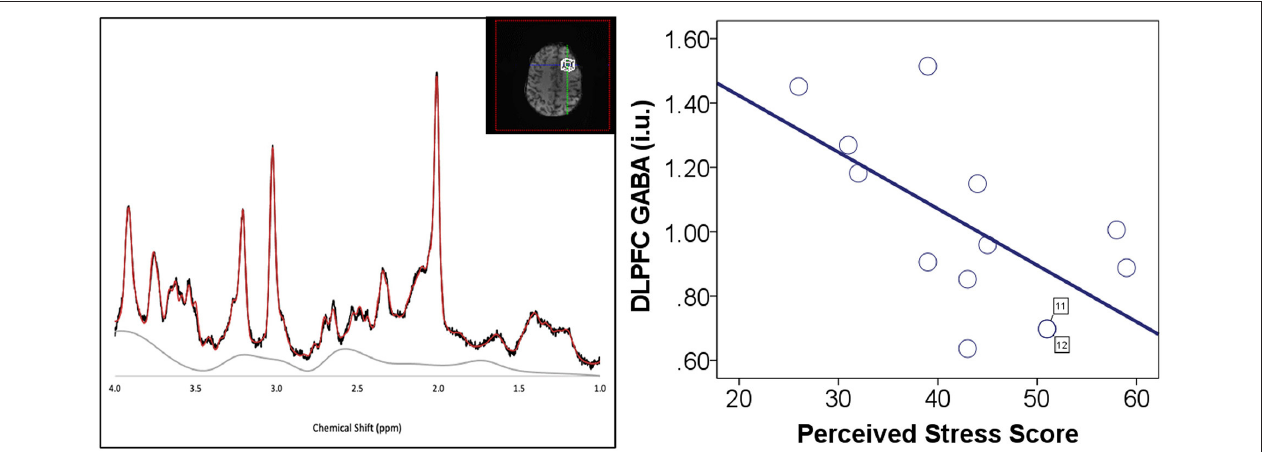
FIGURE 1 | Perceived stress and DLPFC GABA. (Left) DLPFC voxel placement and example of spectrum. (Right) Negative correlation between perceived stress scale (PSS) scores and left DLPFC GABA. DLPFC GABA measurements are in institutional units. There were two participants (cases 11 and 12) with similar values for both DLPFC GABA and PSS score. These data points are labeled with the case number to identify the overlapping data